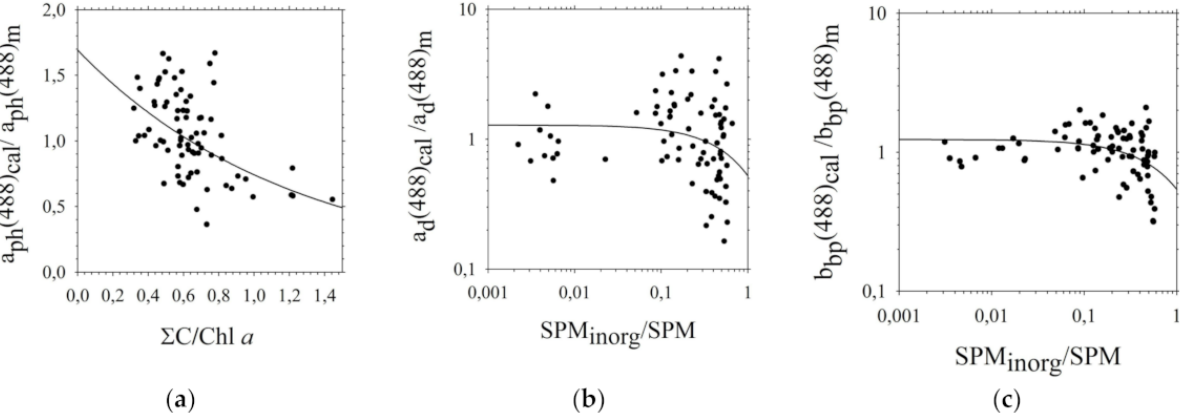
Figure 6. Comparison of: ( a ) a ph calculated using Equation (8) and the ratio of Chl a and ∑ C , ( b ) a d calculated using Equation (12) and the ratio of SPM and SPM inorg , ( c ) b bp calculated using Equation (16) and the ratio of SPM and SPM inorg , (for wavelength of 488 nm) in the selected areas of the southern Baltic [the line approximation by equations ( a ) 27 ( b ) 28 and ( c ) 29] The coefficient of determination ( R 2 ): ( a ) 0.27, ( b ) 0.02, ( c )